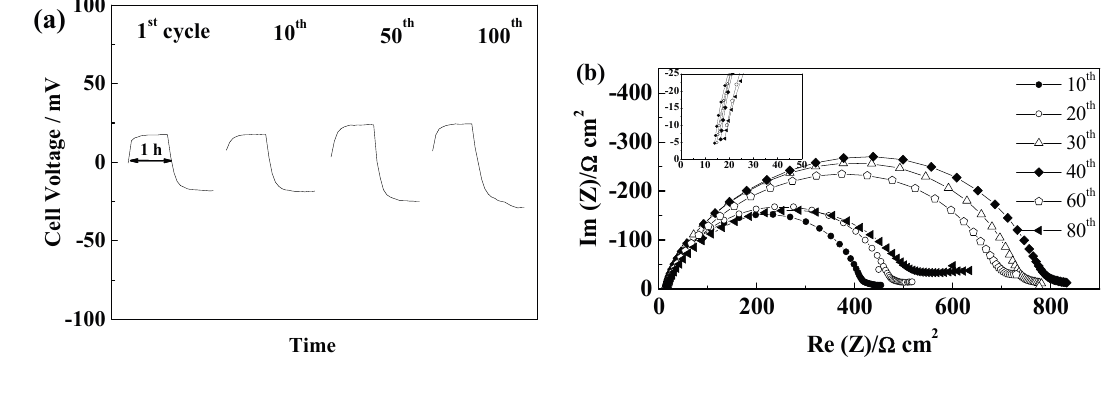
Figure 6. Evolution during cycling at 40 °C and 0.1 mA·cm − 2 of a PYR incorporating a GF/C separator ( a ) Voltage profile of a GF/C cell; and ( b ) Evolution of the impedance spectra at 21 °C of the GF/C